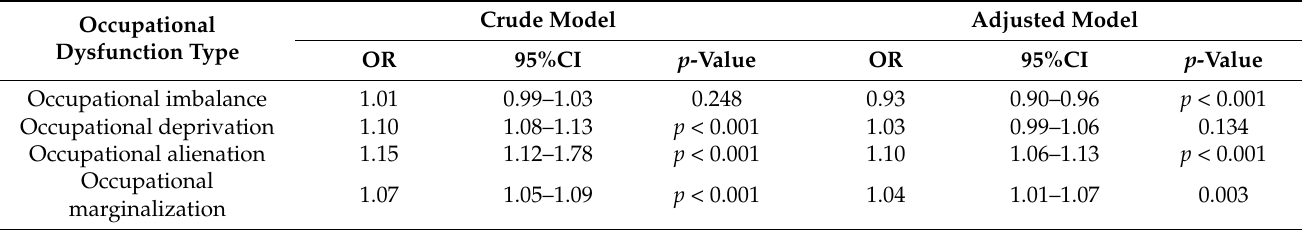
Table 3. Association classification in the relationship between occupational dysfunction and social